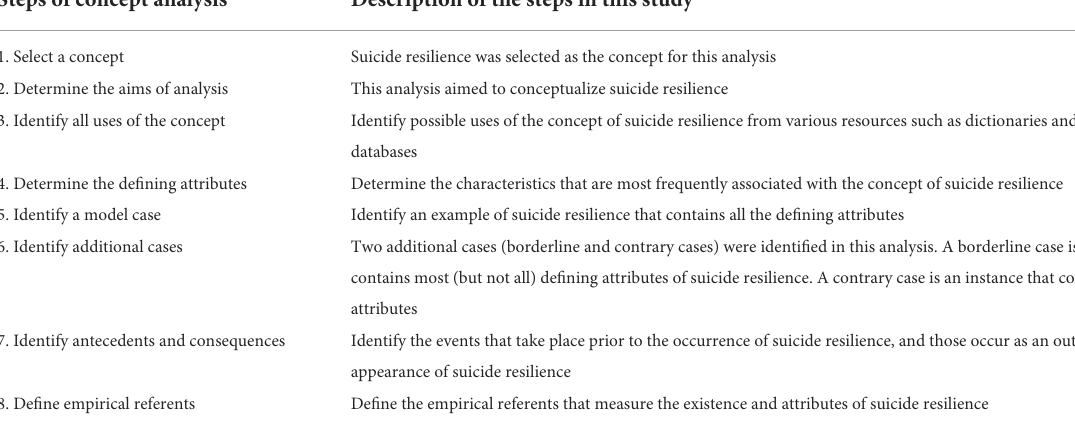
TABLE 1 Adaptation of Walker and Avant steps of concept analysis.